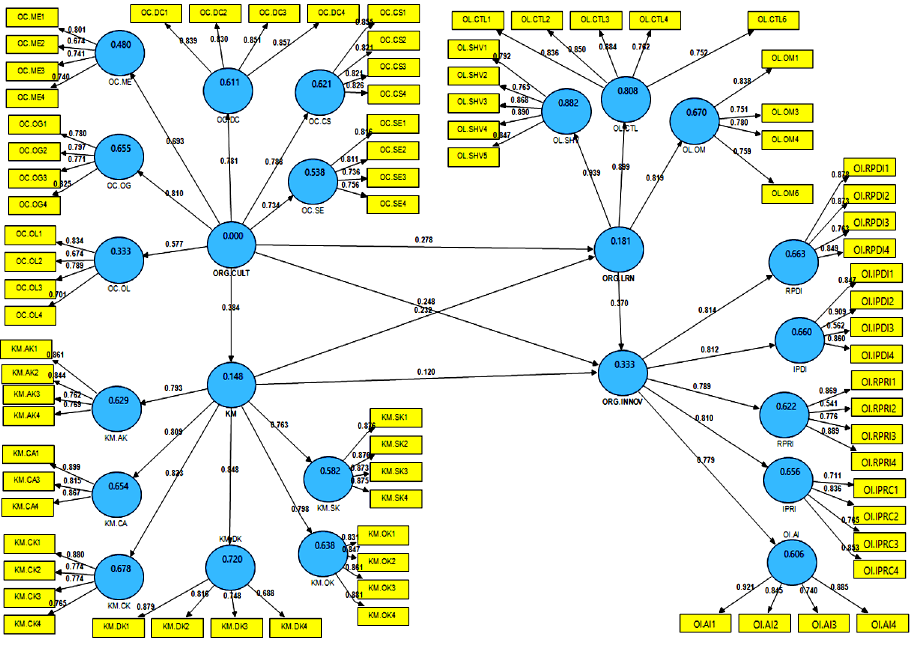
Figure 2. The measurement model with loadings and